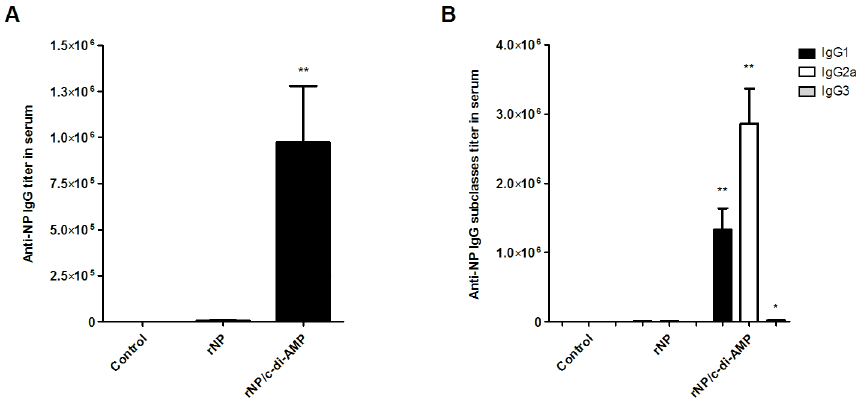
Figure 1. Evaluation of NP specific IgG and IgG subclasses in serum. Anti-NP IgG titers were determined by ELISA on day 60. BALB/c mice (n=5) were vaccinated with two doses of rNP (10 m g/dose) alone or co-administered with c-di-AMP (10 m g/dose) by intranasal route, whereas control animals received PBS, at an interval of 3 weeks. (A) Anti-NP IgG titer. (B) Anti-NP IgG subclass titers. The results are expressed as mean end point titers. The S.E.M. is indicated by vertical lines. Differences were statistically significant at p , 0.01 (**) or p , 0.05 (*) with respect to values obtained in mice receiving the antigen alone.